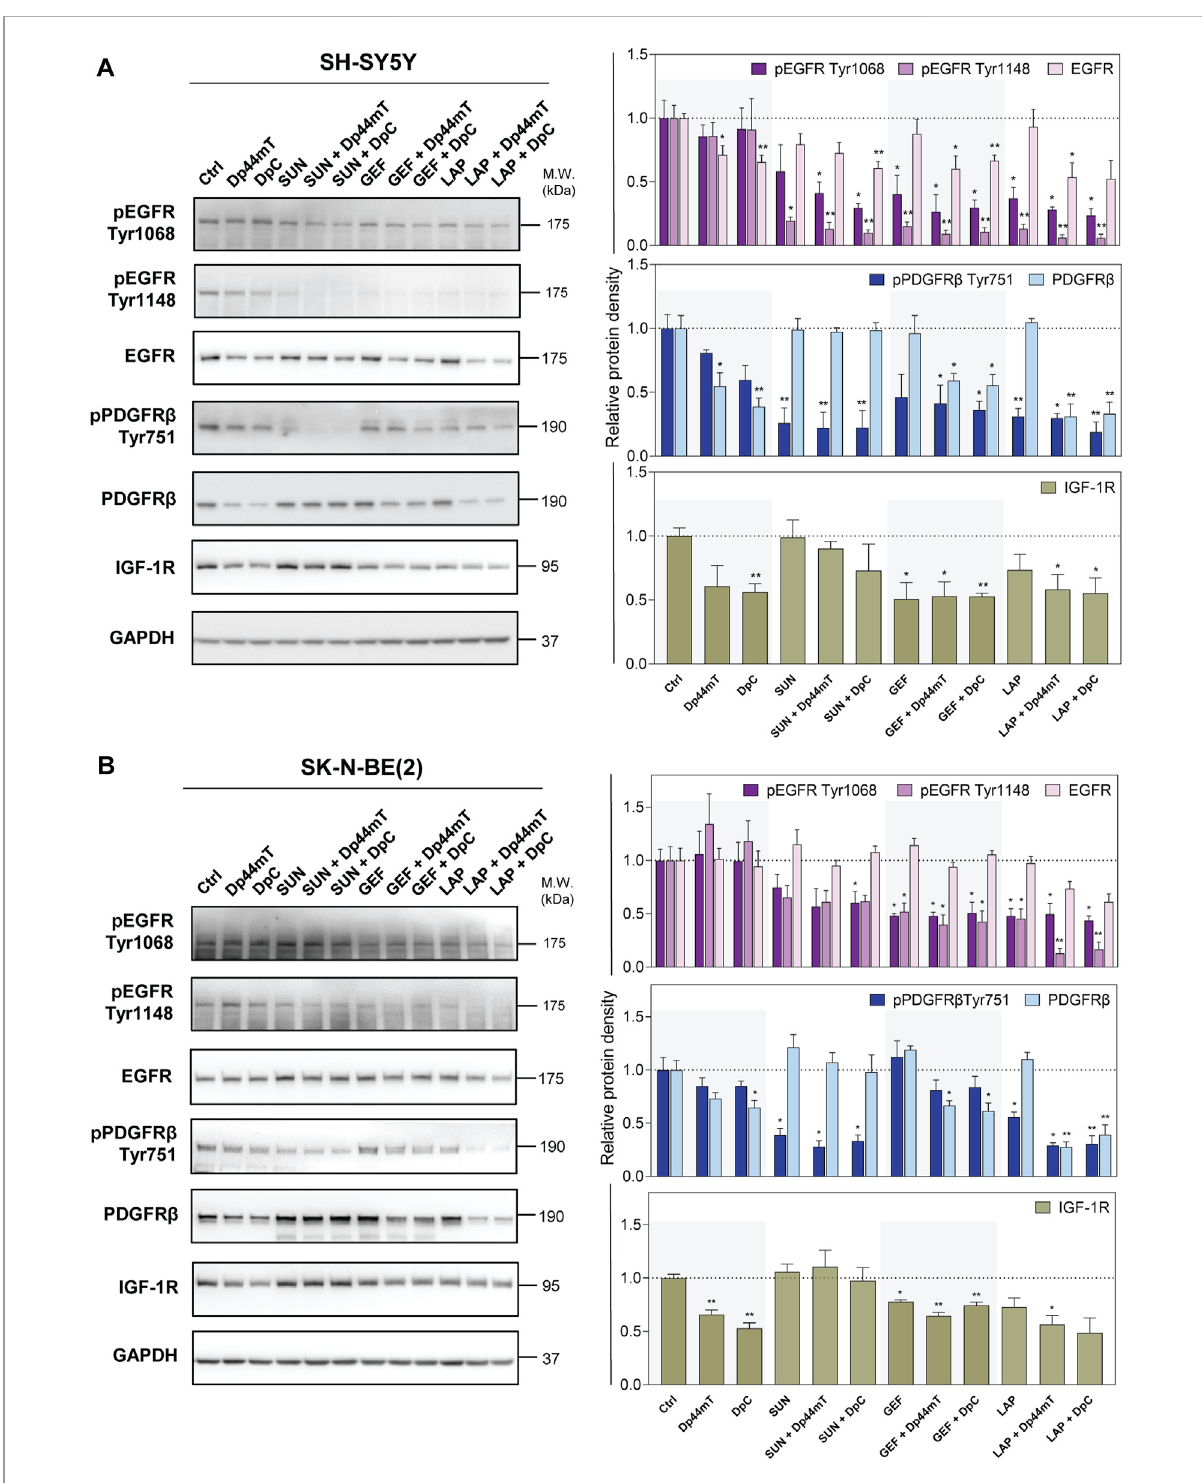
FIGURE 6 Western blotting of the levels of total and phosphorylated selected RTK proteins, including epidermal growth factor receptor (EGFR), platelet- derived growth factor receptor- β (PDGFR β ), and insulin-like growth factor receptor (IGF-1R). The changes in the levels of phosphorylated EGFR (Tyr1068 and Tyr1148) and PDGFR β (Tyr751) and of total EGFR, PDGFR β , and IGF-1R proteins were detected in SH-SY5Y (A) and SK-N-BE(2) (B) cells after a 72-hour incubation with either a control medium or a medium containing the drugs, including TKIs (SUN, GEF, or LAP) and thiosemicarbazones (Dp44mT or DpC) alone or in combination. The drugs were used at concentrations of IC 50 for 72 h as listed in Table 2.